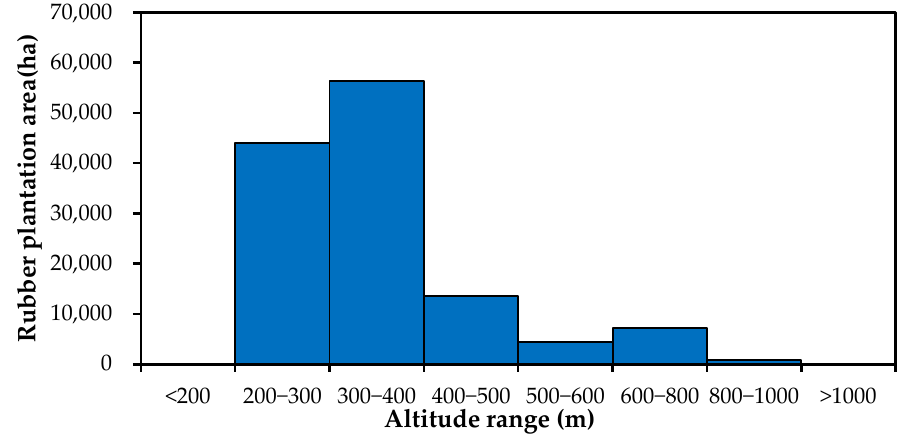
Figure 5. Statistics of rubber plantation areas at different elevations in 2019.